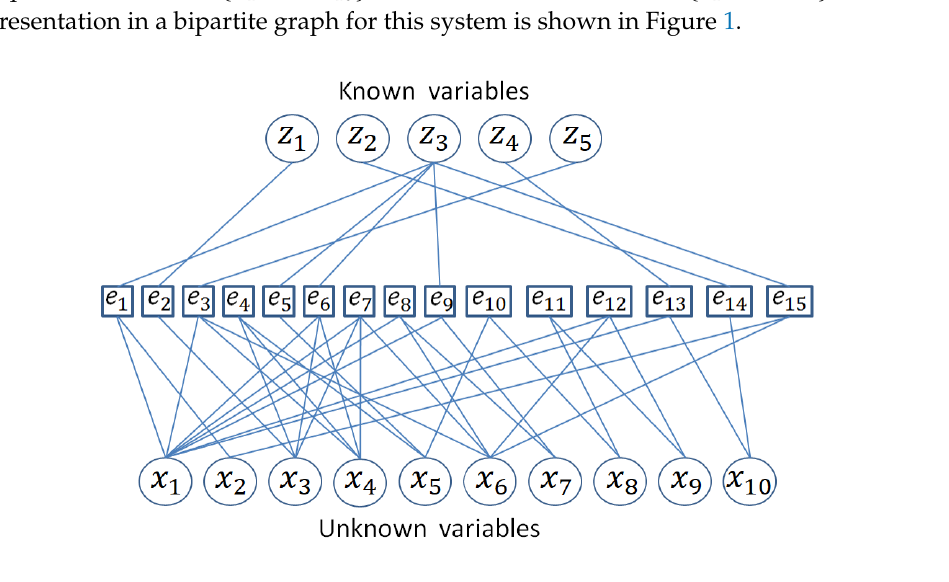
Figure 1. Bipartite graph of an academic